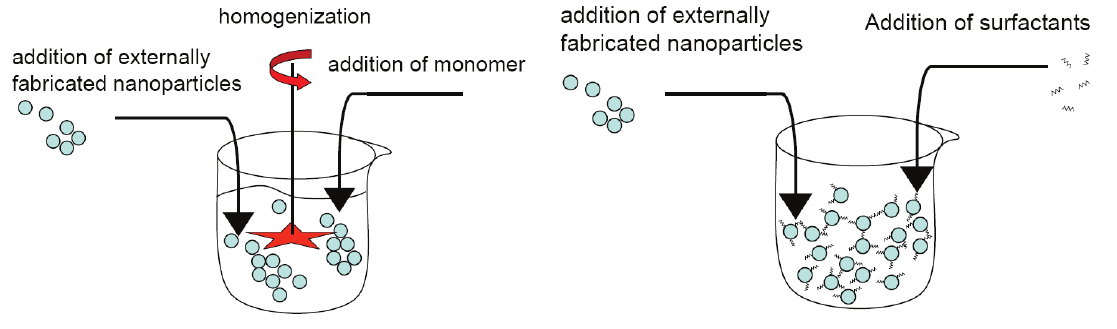
Figure 6. Sketch of dispersing nanoparticles in a monomer, polymer or resin (organic solution) by use of external shear forces, e.g., by a stirrer (left) or by sonification prior to polymerization. In an advanced set-up, the nanoparticles may be coated with a coupling agent/surfactant before mixing (right) with the